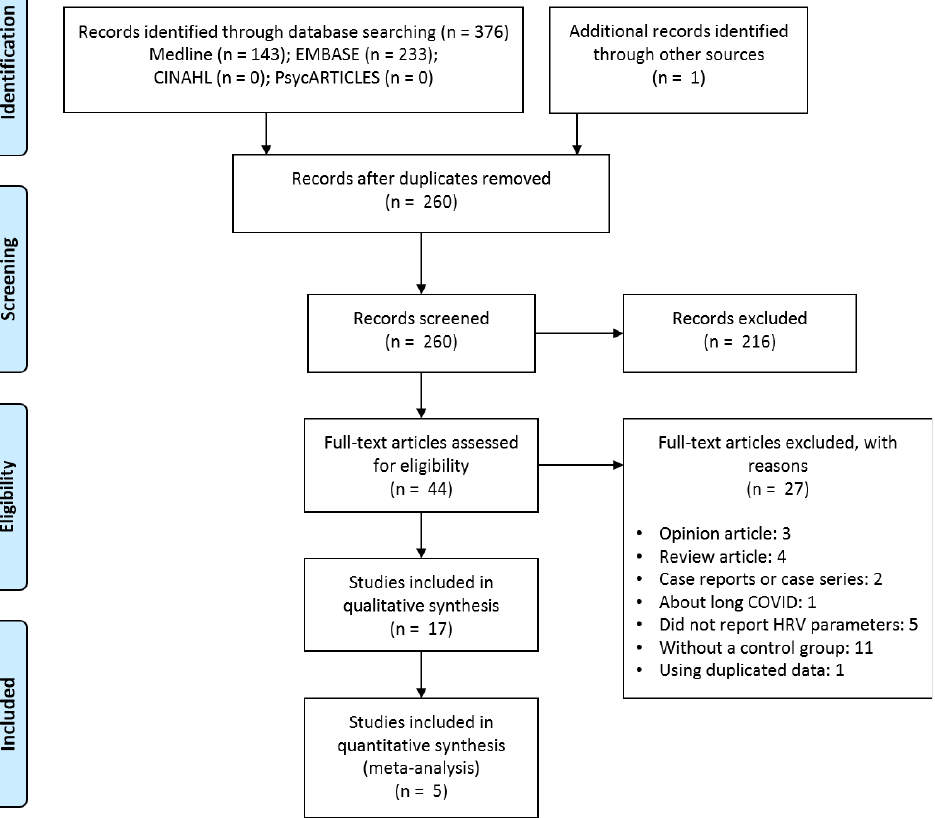
Figure 1. PRISMA flow diagram of this study. Abbreviations: CINAHL, Cumulative Index to Nursing and Allied Health Literature; COVID, coronavirus disease; HRV, heart rate variability.